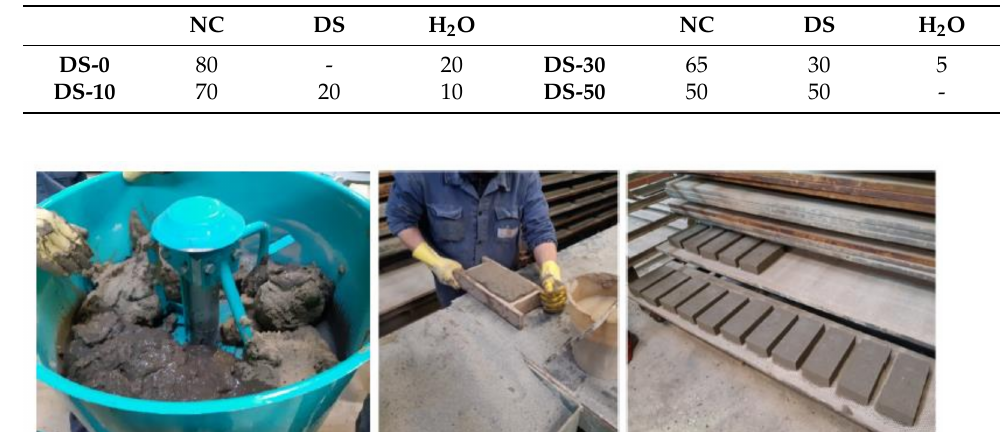
Table 1. Composition of the soft-paste bricks (quantities are reported in percentage by weight, wt%).